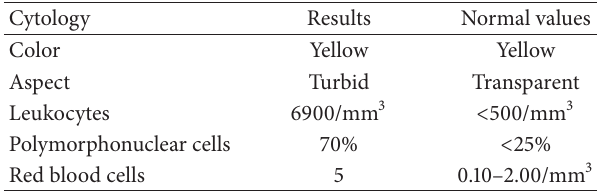
Table 4: Peritoneal fluid